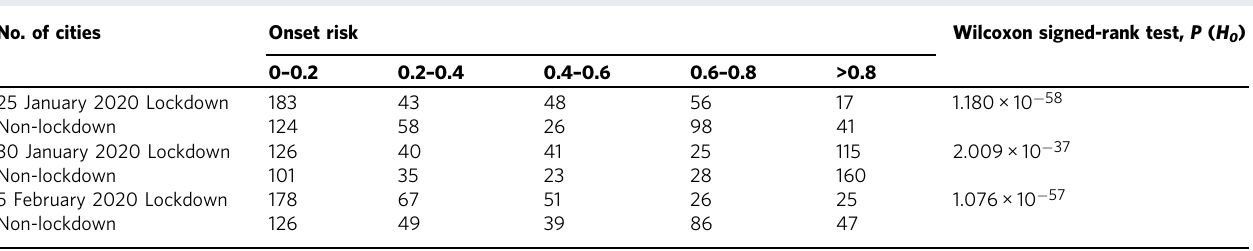
The rightmost column shows the P values of the Wilcoxon signed-rank test on paired onset risk values of a city under two scenarios on the same date. The null hypothesis of this test, H 0 , is that the mediandifferencebetweentheonsetriskvaluesunderlockdownandnon-lockdownscenariosiszero.Ata normalsigni fi cancelevel, H 0 couldberejected,thusshowingthattheonsetriskunderthenon- lockdown scenario is statistically signi fi cantly higher. N = 347 samples on every date were use in each Wilcoxon signed-rank test.